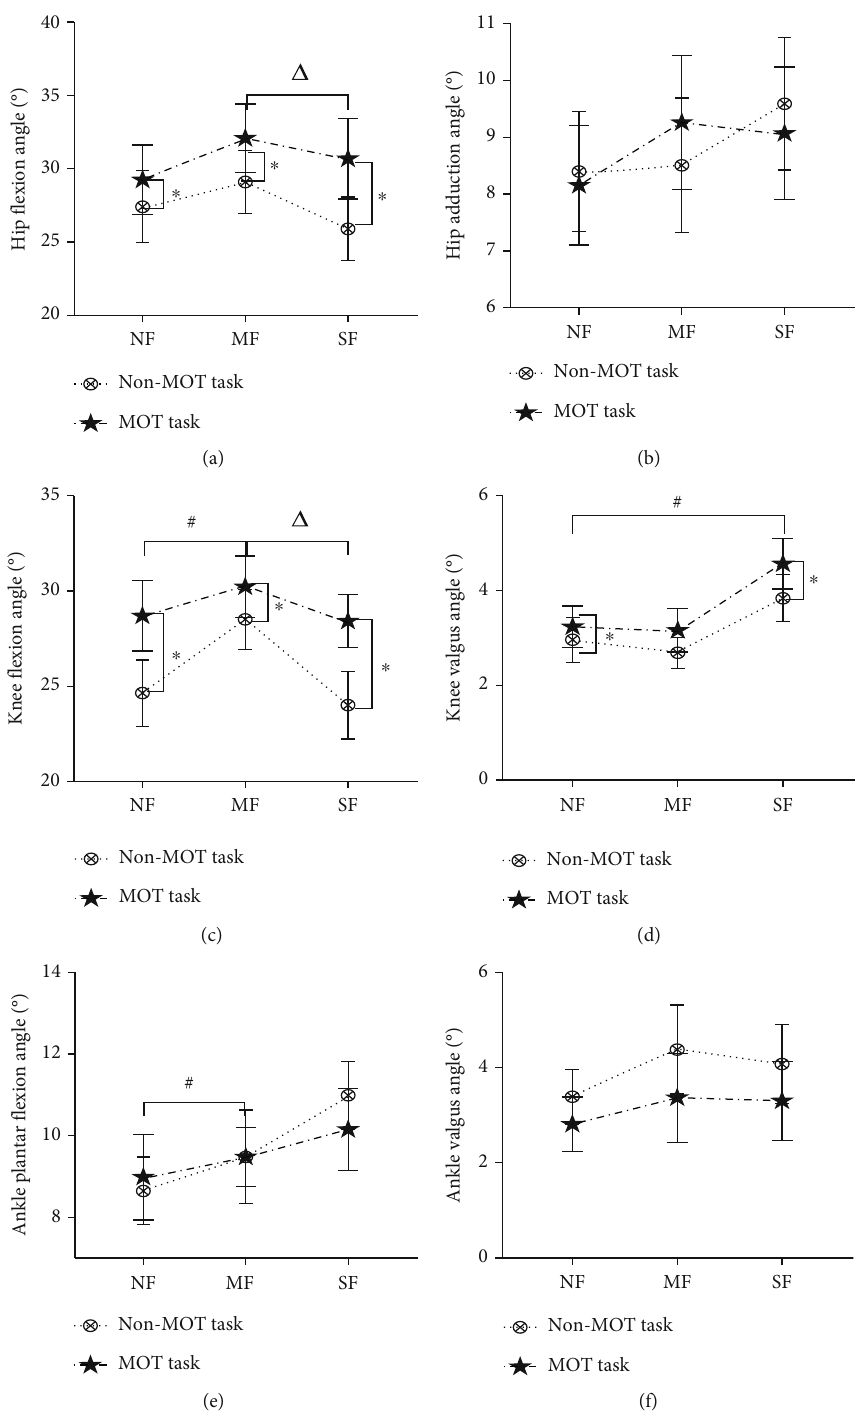
Figure 5: Changes of lower extremity joint angles. Note: ∗ means the indicators under MOT task are signi fi cantly di ff erent compared with no task, P < 0 : 05 ; # means the indicators in MF and SF are signi fi cantly di ff erent compared with NF, P < 0 : 05 ; Δ means the indicators in NF and SF are signi fi cantly di ff erent compared with MF, P < 0 : 05 , the same as